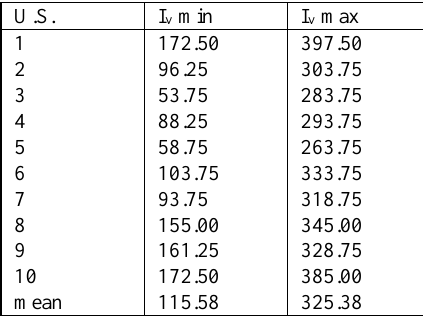
Table 2. The vulnerability index for the buildings in aggregate.